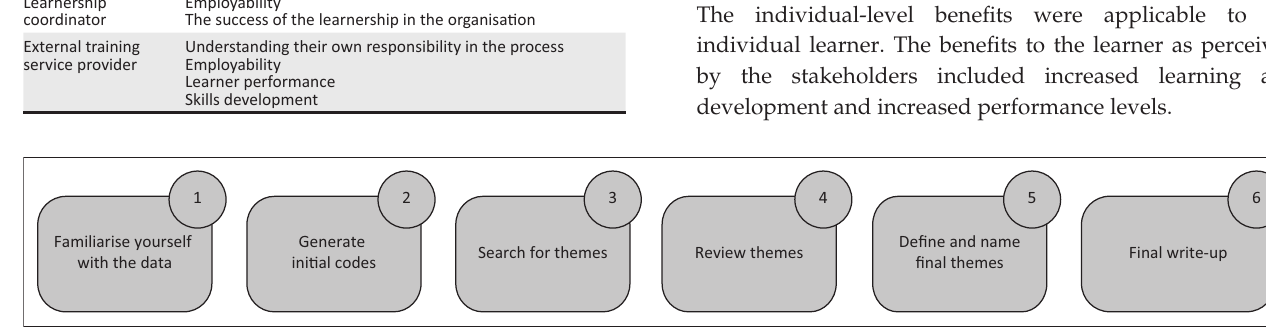
FIGURE 1: The data analysis process.